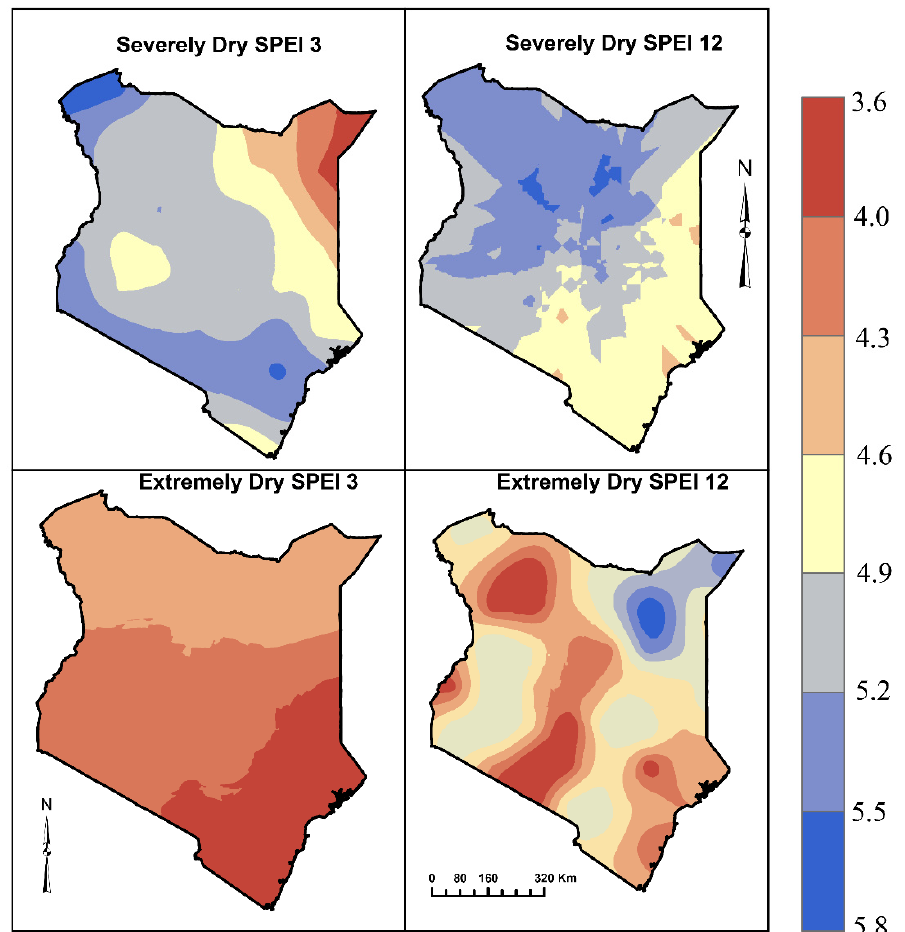
Figure 6. Frequency of severe ( top ) and extreme ( bottom ) dry events computed for SPEI-3 and SPEI-12, respectively, over Kenya, 1981–2016.